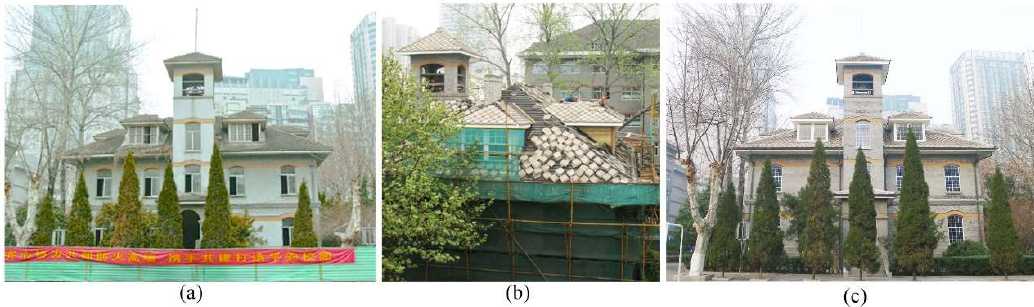
Figure 19. Photos of the bell tower before, during, and after repairs (source: author). ( a ) Before conservation. ( b ) Renovation in progress ( c ) After conservation.